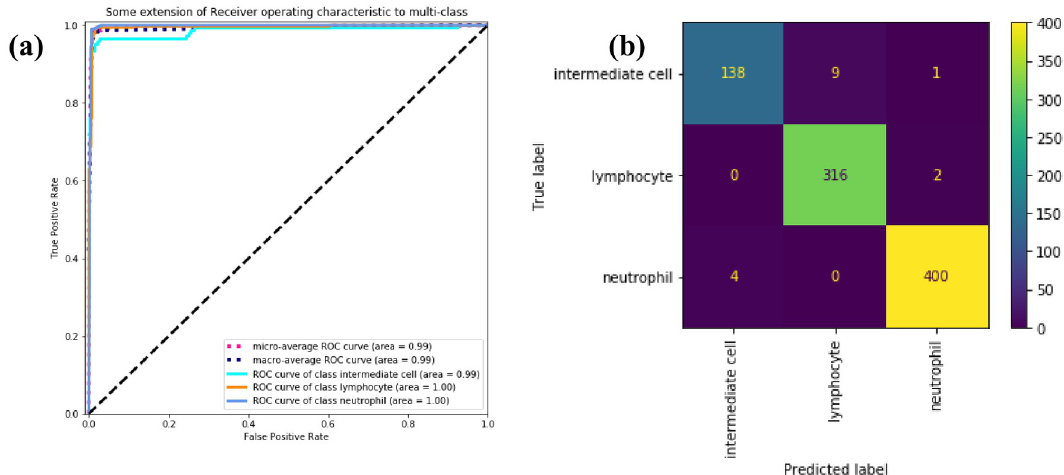
Fig 8. ROC curve and confusion matrix. (a) ROC curve of three subtypes of WBC. (b) confusion matrix of three subtypes of WBC.